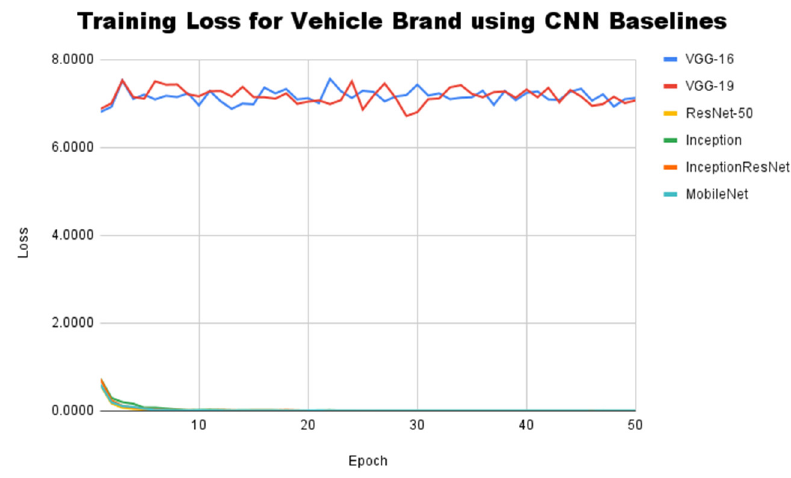
Figure 6. Training loss for vehicle brand classification using CNN baseline architectures.